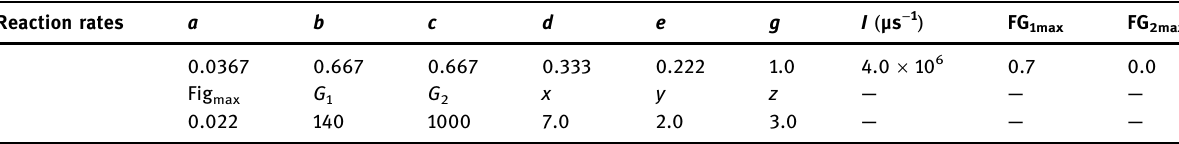
Table 6: Parameters of ignition growth model for CompB Lee – Tarver Reaction